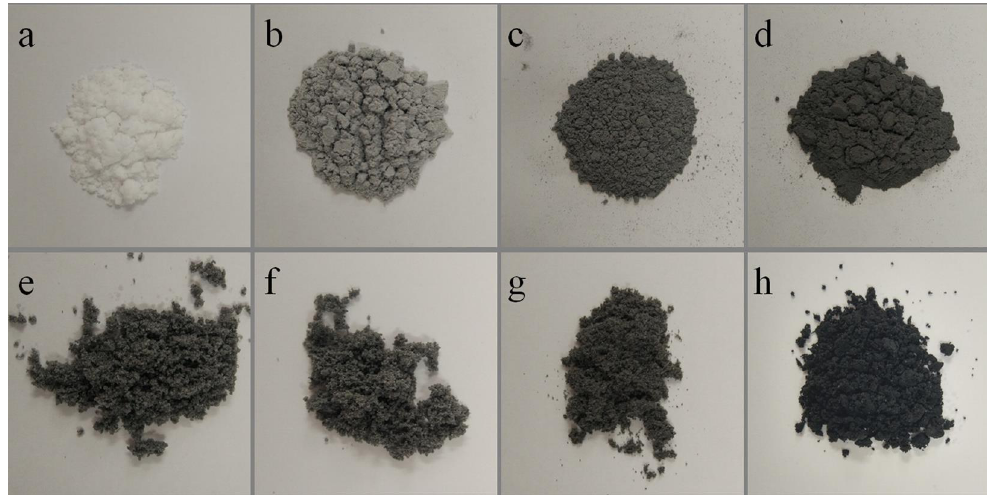
Figure 5. Photographs of self-healing microcapsules without various weight contents graphene in shells, ( a ) 0%, ( b ) 0.5%, ( c ) 1.0%, ( d ) 2.0%, ( e ) 4%, ( f ) 6%, ( g ) 8% and ( h ) 10%. shells, ( a ) 0%; ( b ) 0.5%; ( c ) 1.0%; ( d ) 2.0%; ( e ) 4%; ( f ) 6%; ( g ) 8% and ( h )